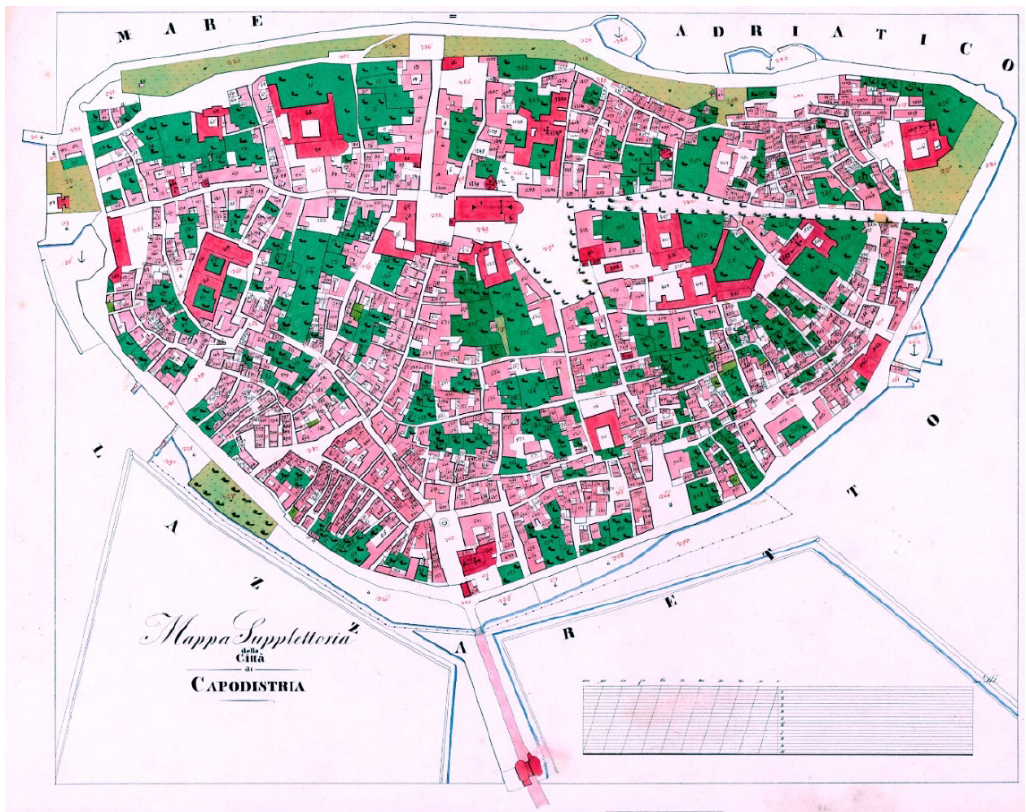
Figure 6. Map of Koper by The Franciscean or Stable cadastre from 1819. Source: Archivio di Stato di Trieste